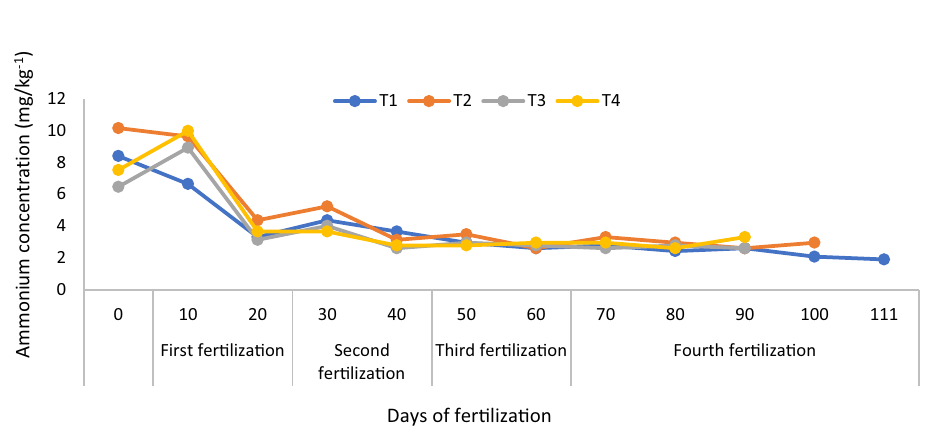
Figure 3. Improving soil ammonium content availability using chicken litter biochar in MR219 rice cultivation.